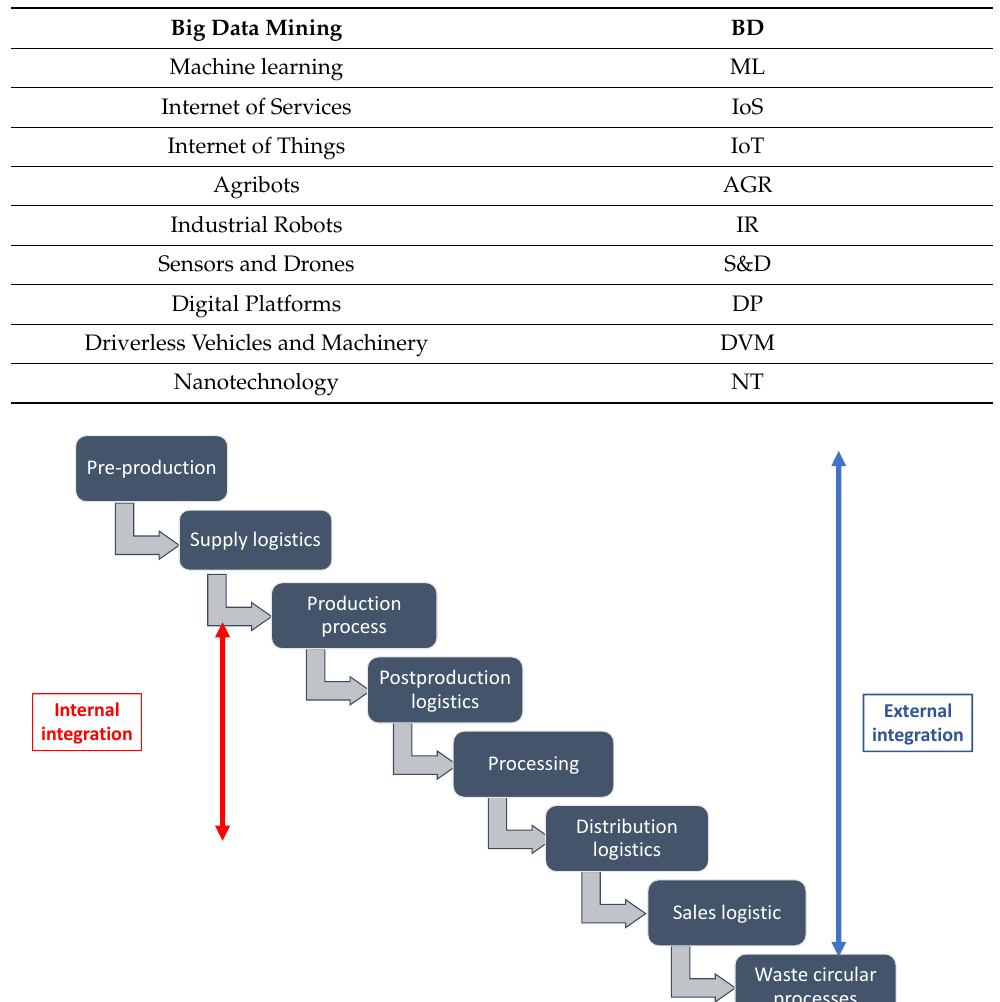
Table 2. Artificial Intelligence connected and embedded technologies.